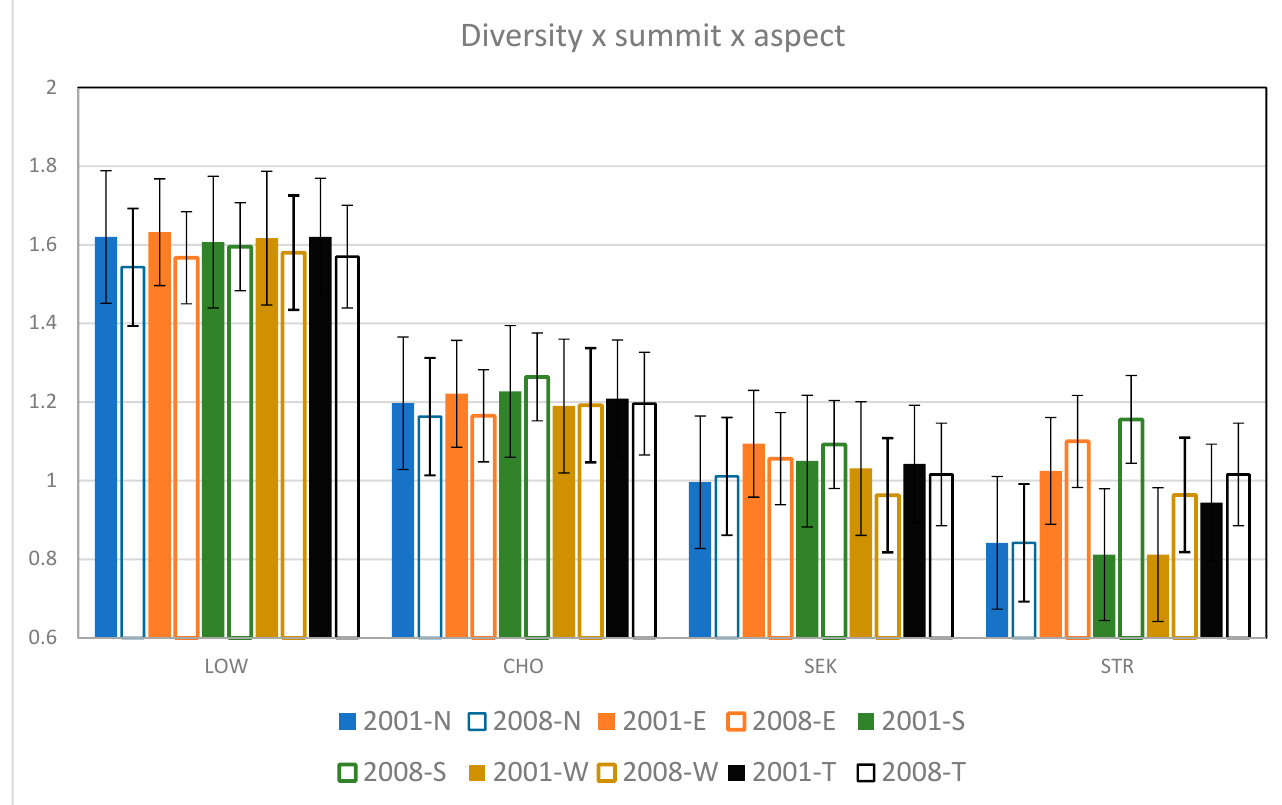
Figure 3. Species diversity per summit per aspect for the two monitoring periods. (N: North, S: South, E: East, W: West, T: Total Summit) . LOW: low summit, CHO: Chorafas, SEK: South East Kakovoli, STR: Sternes